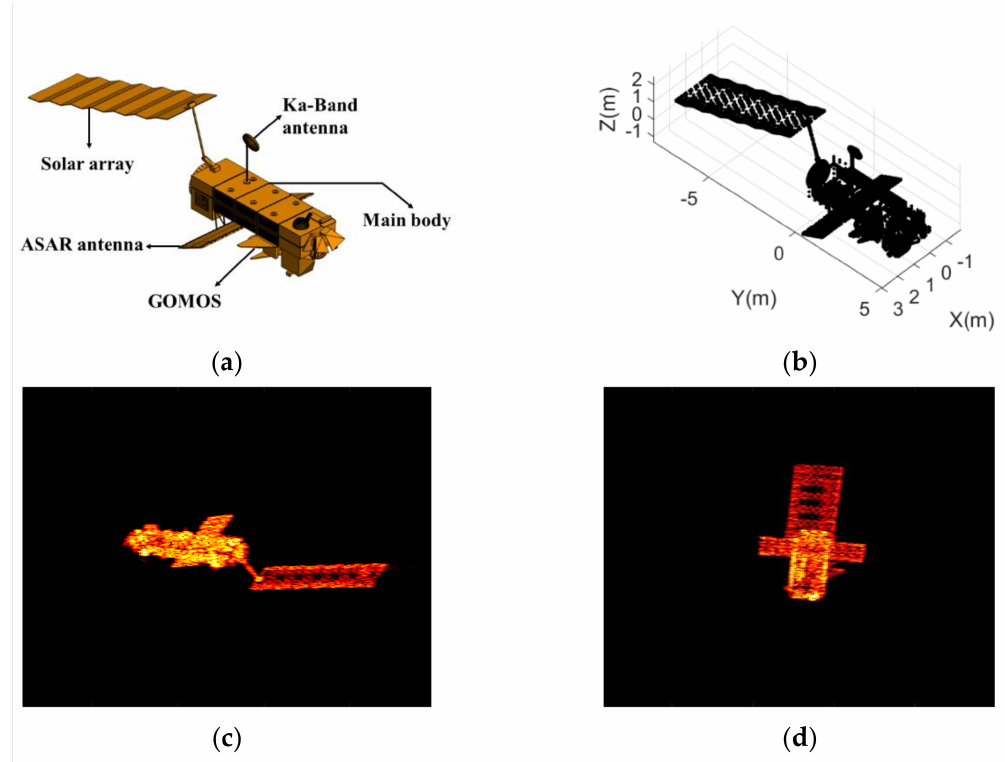
Figure 10. Simulated point model of ENVISAT and corresponding to the ISAR image sequence: ( a ) CAD model of ENVISAT, ( b ) simulated point model of ENVISAT. ( c ) and ( d ) the 13th and 24th frames,